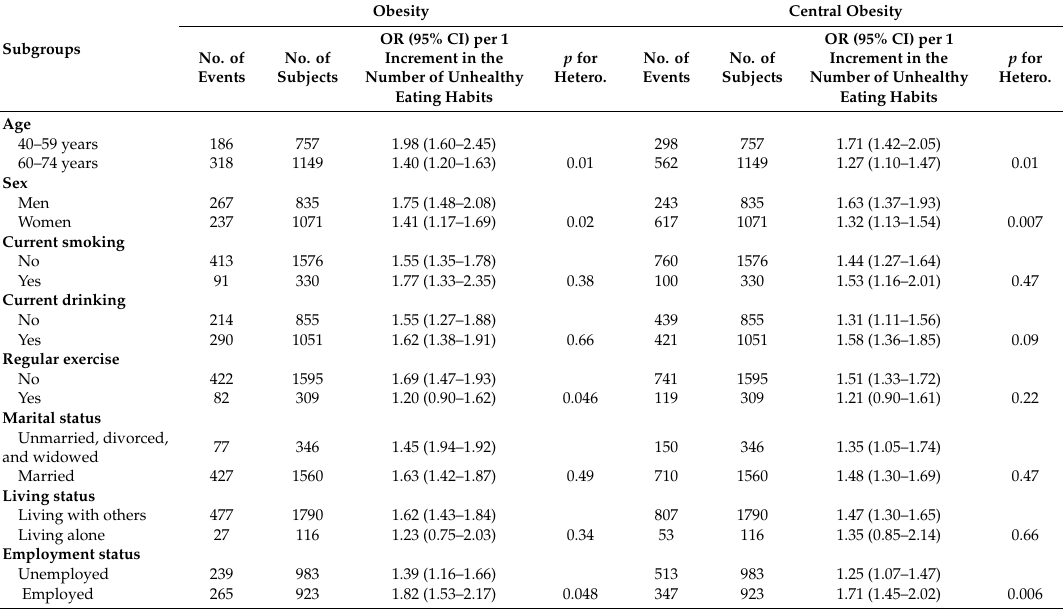
Table 4. Age- and sex-adjusted odds ratios and 95% confidence intervals of the presence of obesity and central obesity per every one increment in the number of accumulated unhealthy eating habits in the subgroups of covariates. Obesity Central Obesity OR (95% CI) per 1 OR (95% CI) per 1 p for p for No. of No. of Increment in the Increment in the No. of No. of Hetero. Events Subjects Number of Unhealthy Number of Unhealthy Events Subjects Eating Habits Eating Habits